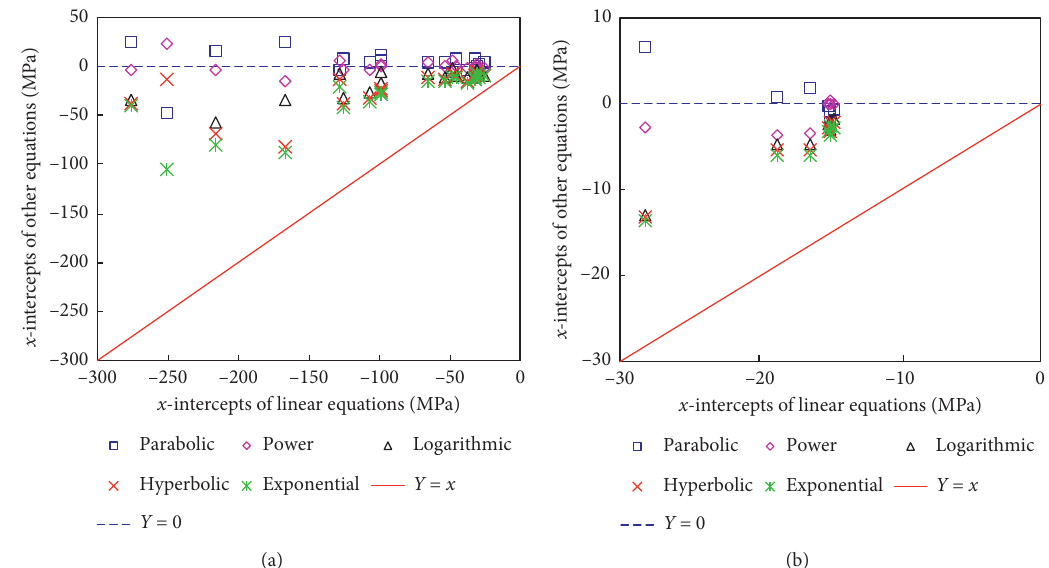
Figure 7: The x -intercepts of the regression strength envelopes. (a) ( σ